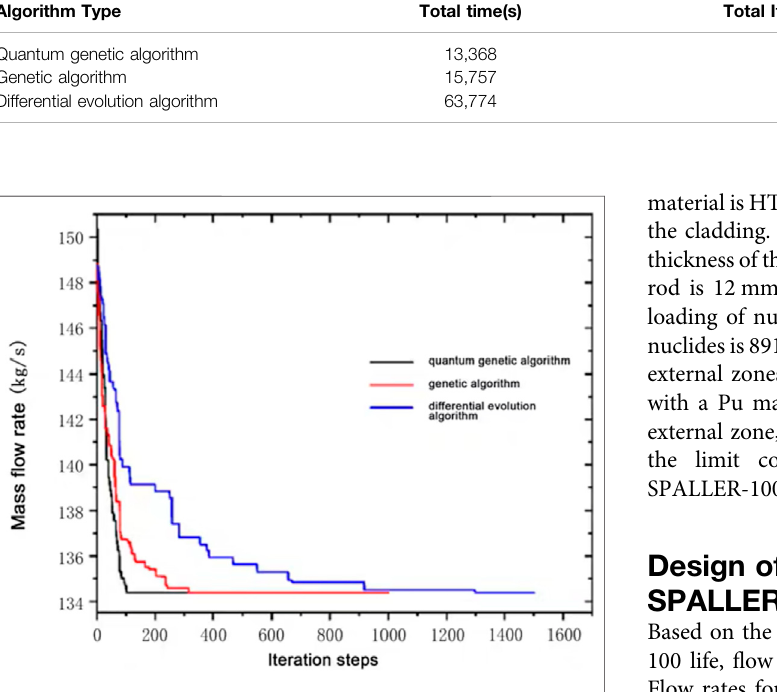
FIGURE 5 | Adaptive curves of the three intelligent